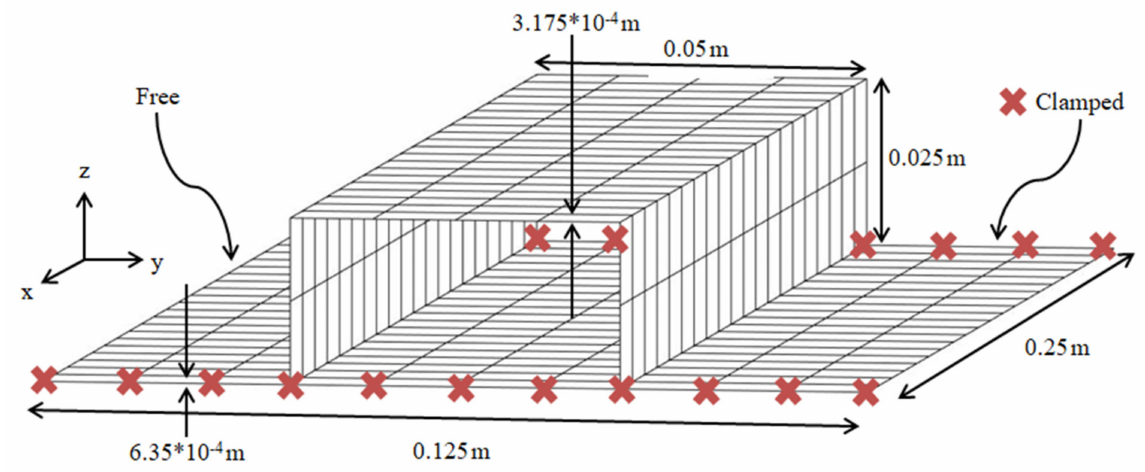
Figure 22. Hat stiffened panel geometry, boundary conditions, and finite element model.